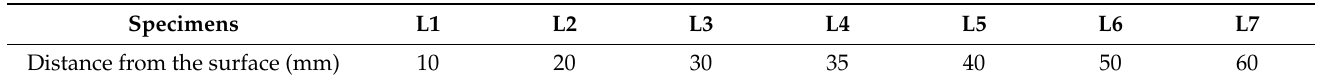
Table 2. Position of the